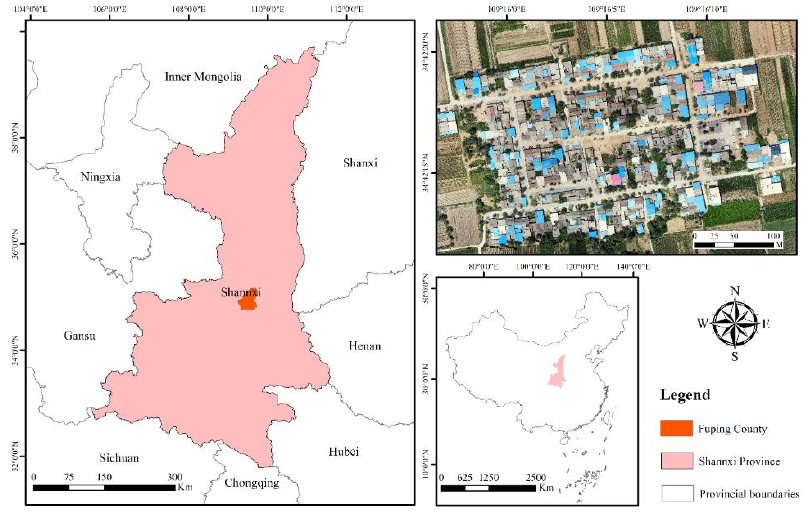
Figure 1. The geographical location of the study area.